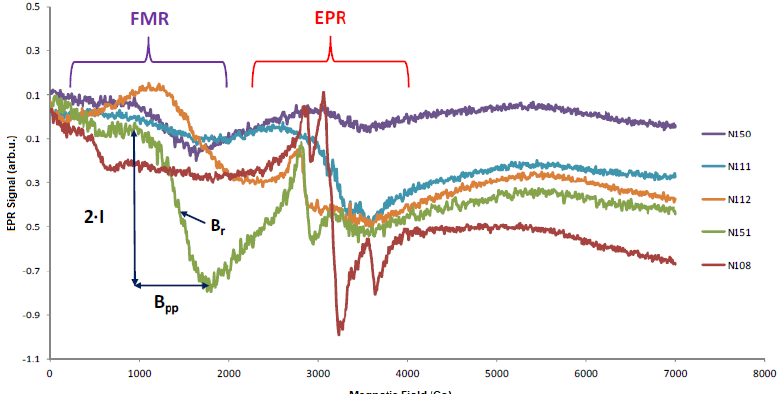
Figure 1. EPR measurements of PbTe (N111), PbTe (N112), PbTe (N150), PbTe:In (N151), and PbSe (N108) at room temperature. FMR-line area for ferromagnetic resonance, EPR- line area for para- magnetic resonance, B pp -peak-to-peak width of the resonance line, I-resonance line intensity, and B r -resonance field.